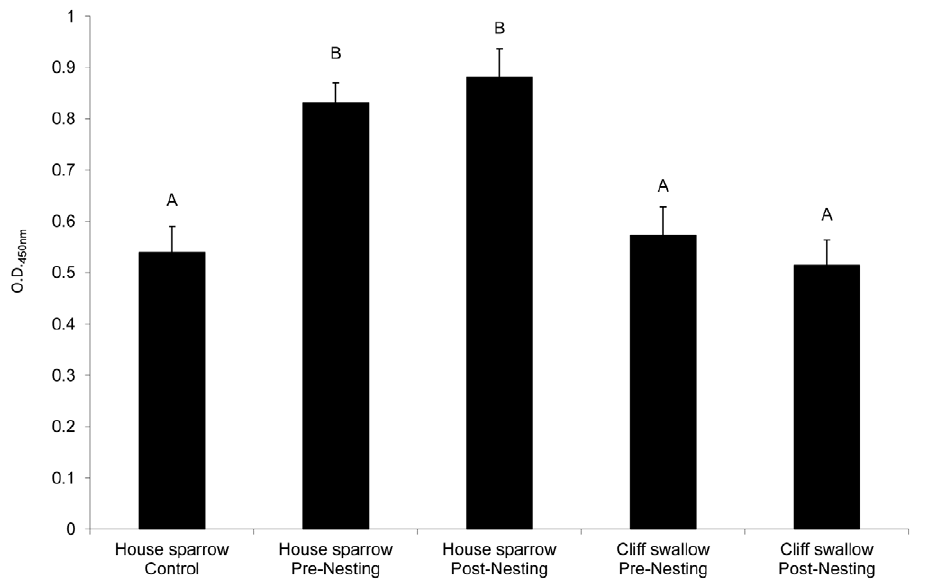
Figure 3. Swallow bug ELISA. Values shown represent mean ( + SEM) swallow bug-specific IgY levels in each group. Letters above bars denote statistical differences among groups ( P , 0.05); bars not sharing the same letter are different.